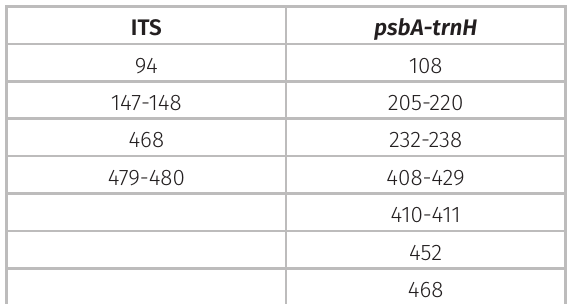
Table I. Positions in the alignment of the informative indels coded for each